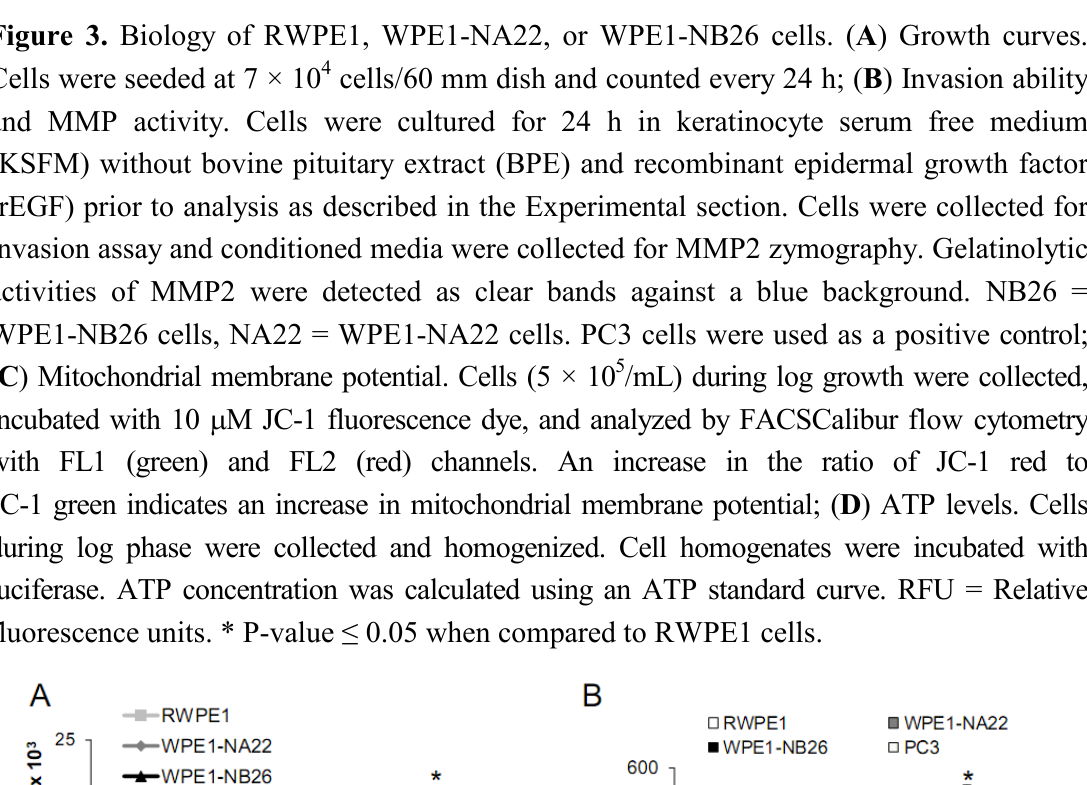
fluorescence units. * P-value ≤ 0.05 when compared to RWPE1